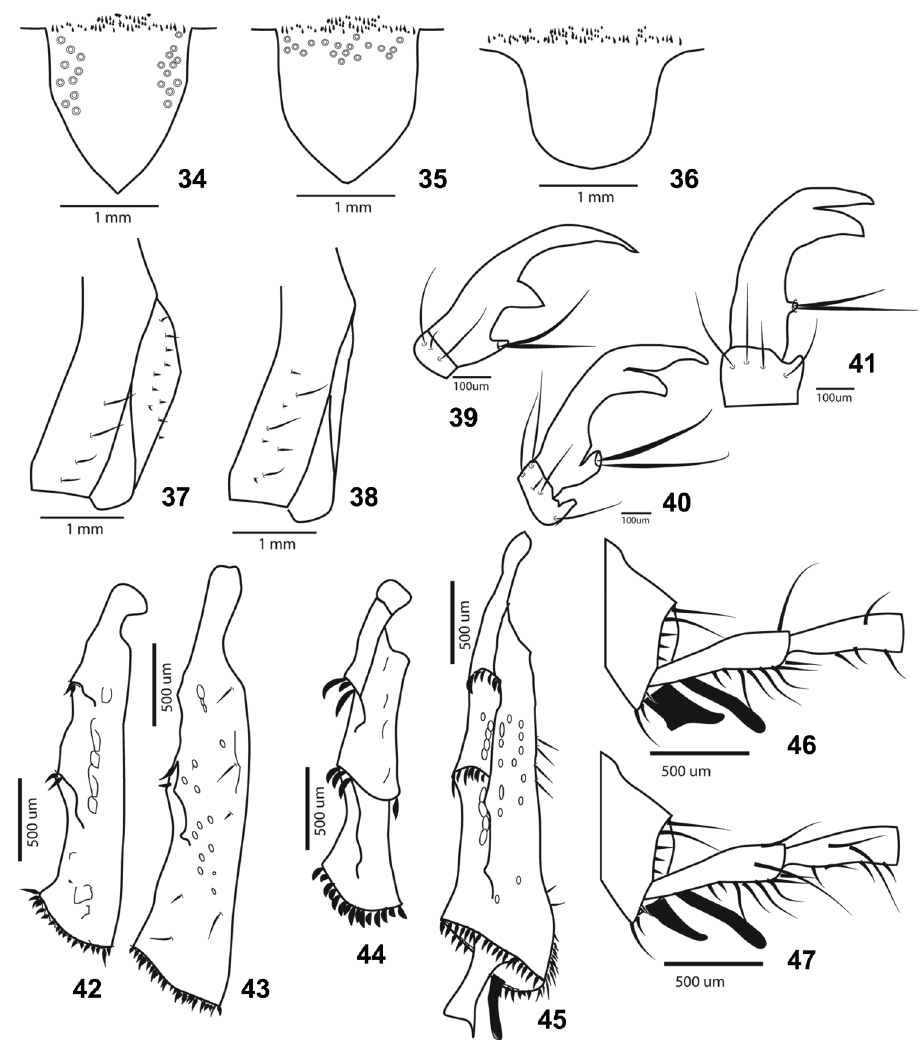
rior tooth-like projections; sensorial area of the maxillary distal palpomere grooved and in a dorso-lateral position (except P. lucida Blanchard); constriction between pro- and pterothorax prominent; distance between meso- and metacoxae equal to metacoxae length (in common with L. concolor (Blanchard)); apical tooth of protibiae oblique to the longitudinal axis; inner margin of mesotibiae concave; lateral margin of metacoxae oblique towards pygidium; metatibial inner margin bent and produced apically; apex surface convex at the insertion point of the tarsomere, gap between apical spurs wider than the base of a single spur. Homalochilus shares the same features with Liogenys